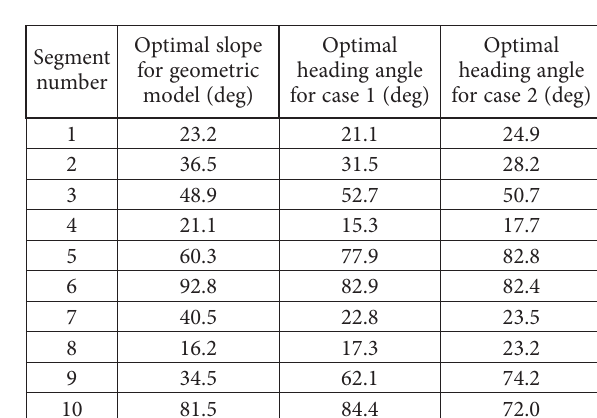
Figure 6. Ten-stage optimal path comparison in scenario 1 Table 2. Optimization results of heading angle for